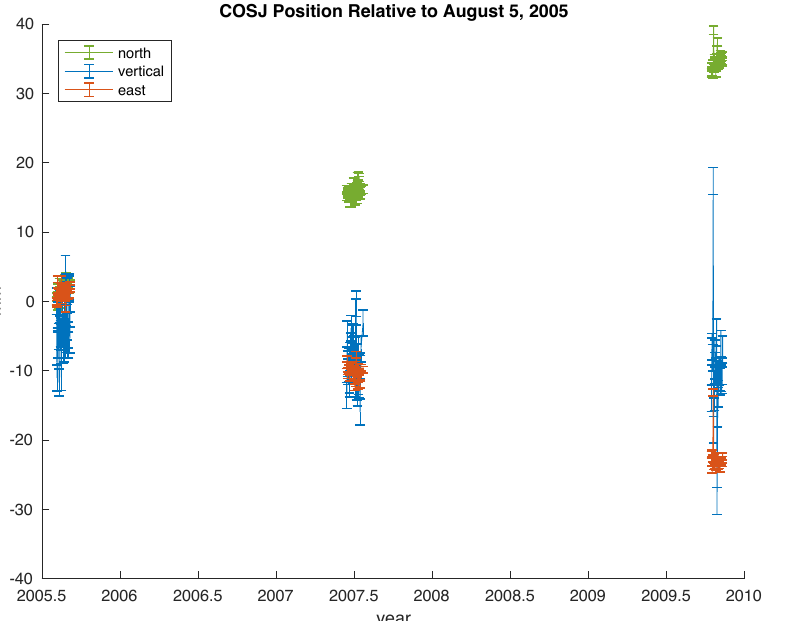
Figure 5. Time series of relative position in three components for campaign GPS station COSJ. Measurements are shown with respect to 5 August 2005. Plotting conventions are the same as Figure